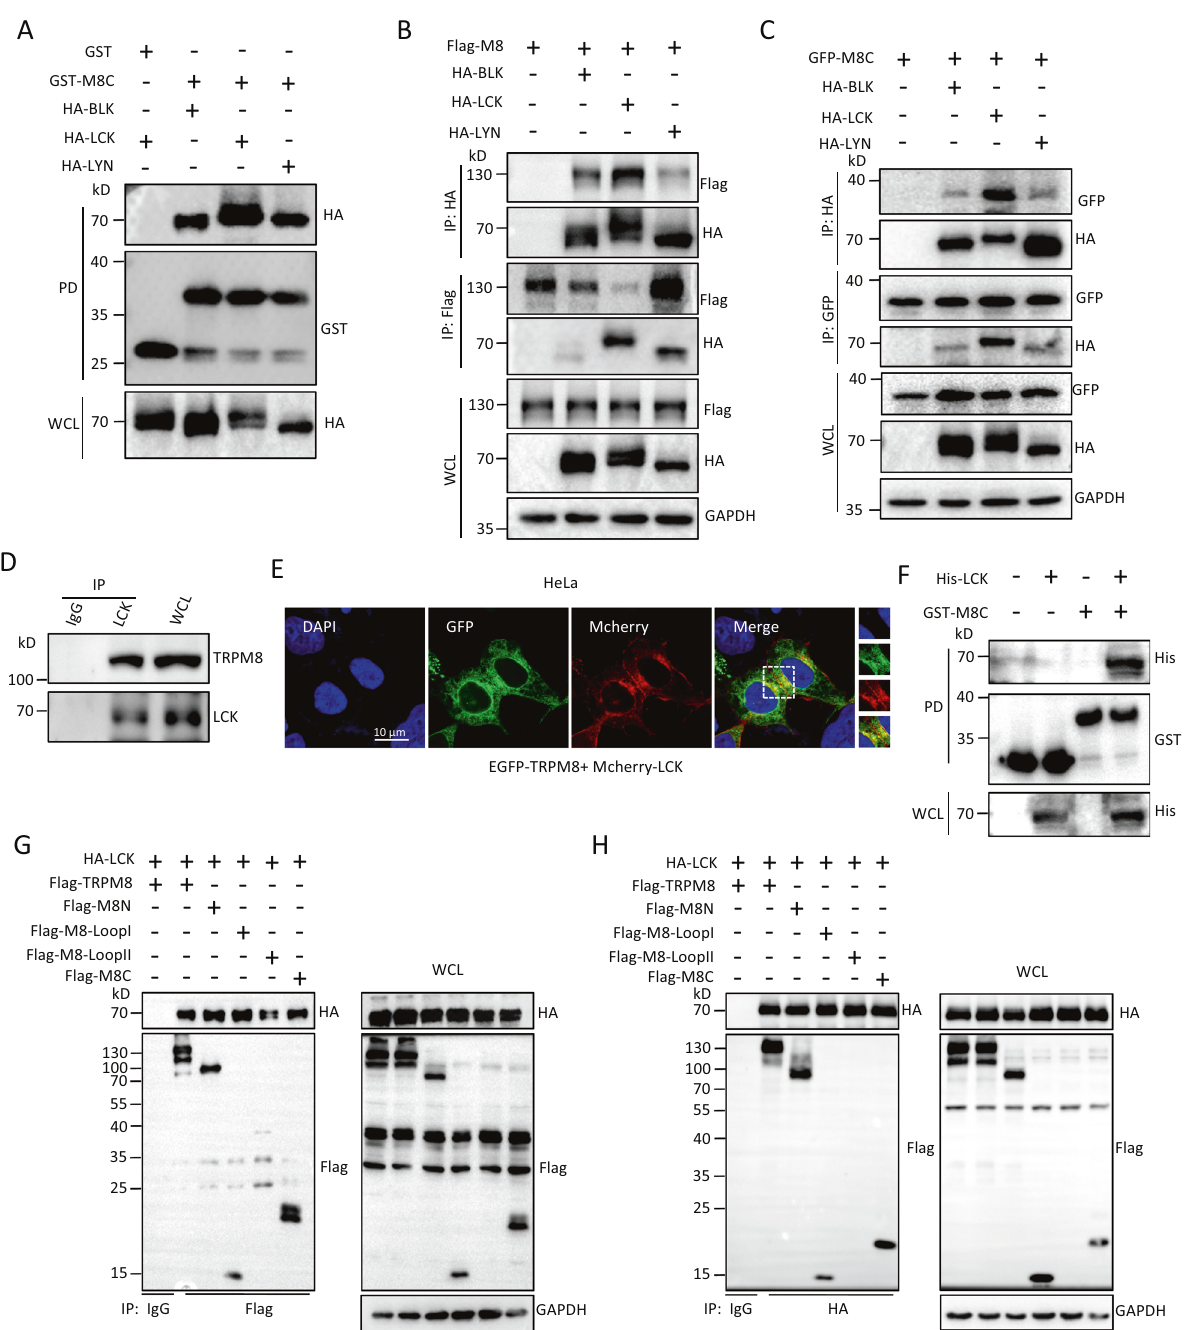
Fig. 1 Src family kinases for BLK, LCK, and LYN interaction with TRPM8. A GST pull-down assays to assess the interaction between puri fi ed GST-tagged C-terminus of TRPM8 (GST-M8C) expressing in E. coli BL21 bacteria and different HA-tagged Src family kinases expressing in HEK293T cells. Western blotting (WB) was performed using the indicated antibodies. B – D Co-immunoprecipitation (Co-IP) assays. B HeLa cells were transfected with the indicated constructs along with Flag-tagged full-length TRPM8 (Flag-TRPM8). Immunoprecipitation (IP) was performed with an anti-HA or anti-Flag antibody, and the samples were analyzed by immunoblotting with the indicated antibodies. C Similar Co-IP in ( B ) but with protein extracts from HeLa cells co-transfected with the indicated constructs along with GFP-tagged C-terminus of TRPM8 (GFP-M8C). D Co-IP as in ( B ) and ( C ) but with protein extracts from native PANC-1 cells. E Representative confocal imaging of co-localization of mcherry-LCK and GFP-TRPM8 in HeLa cells. Overlay images show co-localization of green signals (TRPM8) and red signals (LCK), which generated yellow signals in HeLa. Nuclei were stained with DAPI (blue). Scale bars, 10 µm. F Assay of the interaction in vitro between puri fi ed His-LCK fusion and GST-tagged C-terminus of TRPM8 (GST-M8C) from E. coli bacteria. G , H HEK293T cells co-expressing HA-LCK constructs with a series of mutant Flag-tagged cytoplasmic domain of TRPM8 were harvested for Co-IP assays. All studies were repeated at least three times. GFP, green fl uorescent protein. All studies were repeated at least three